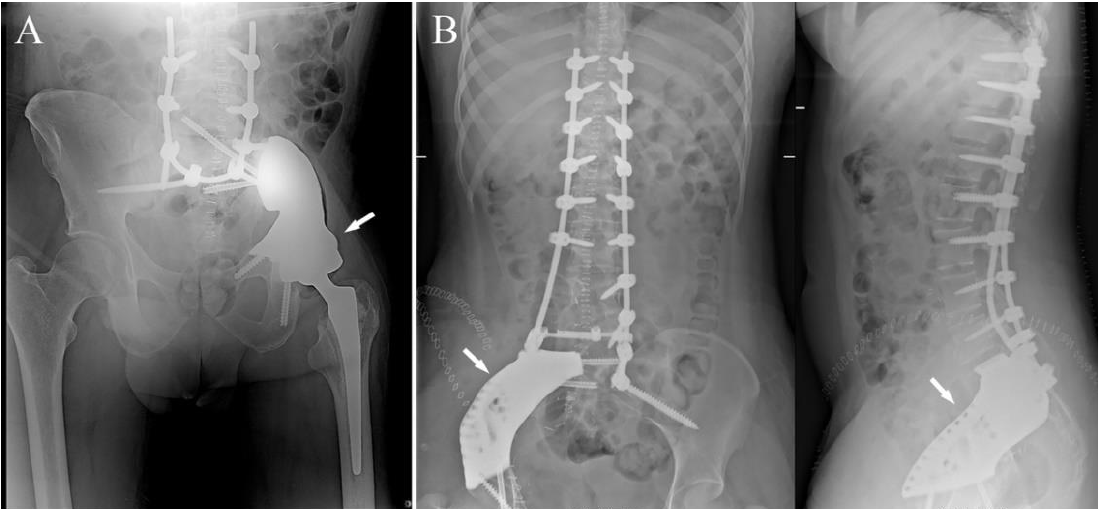
Figure 5. ( A ) post-operative X-ray showing reconstruction after resection of a Ewing sarcoma of the left hemipelvis with sacrum-iliac involvement; reconstruction was performed with a standard femoral stem prosthesis and a dual-mobility cup cemented in a 3DPTCMP (white arrow) linked to a spine stabilization to neutralize the cutting forces acting on the bone–prosthesis interface (case 7); ( B ) post-operative X-ray showing reconstruction after resection of a mesenchymal high-grade chondrosarcoma of the right sacrum-iliac joint; reconstruction was performed with a 3DPTCMP (white arrows) linked to a long spine stabilization (case 14). The two surgeries were performed by two different surgeons in the two different hospitals; the length of spine stabilizations was due to personal